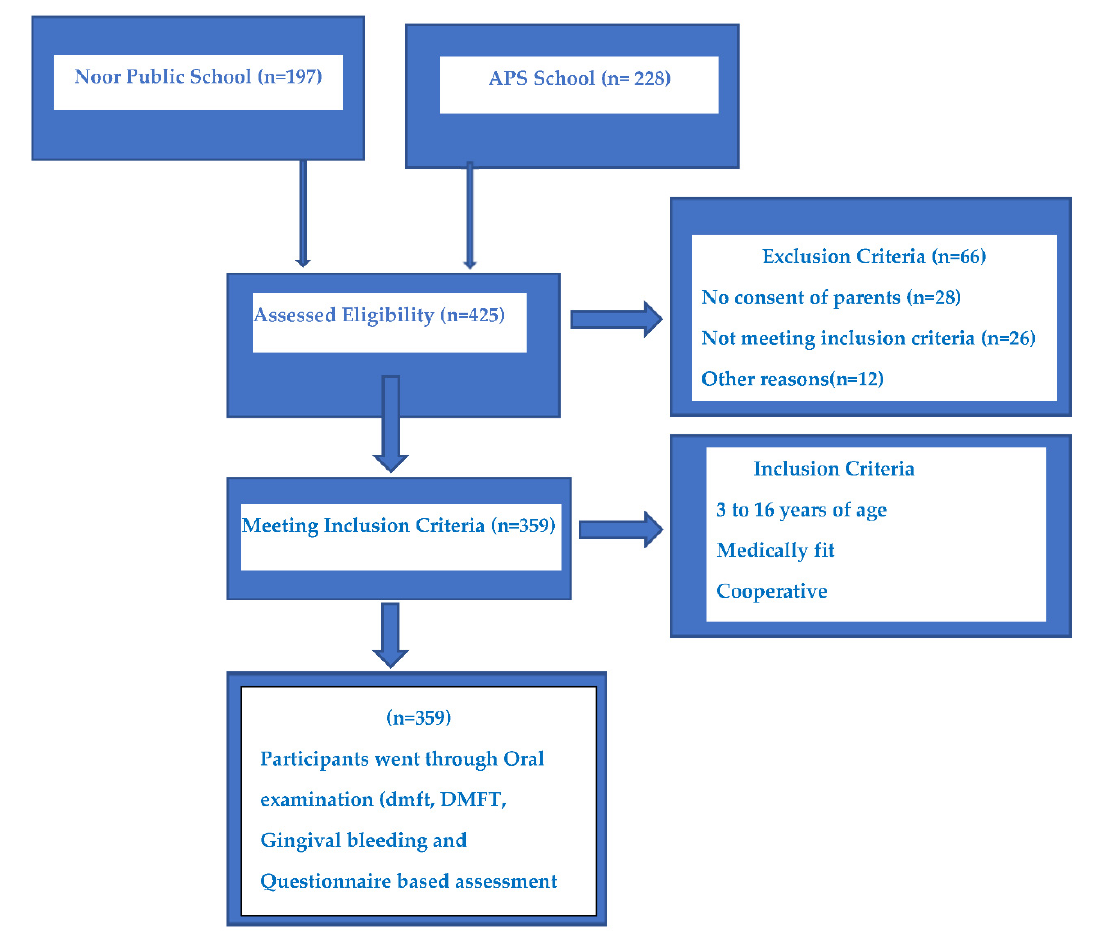
Figure 1. Flow diagram of the study.